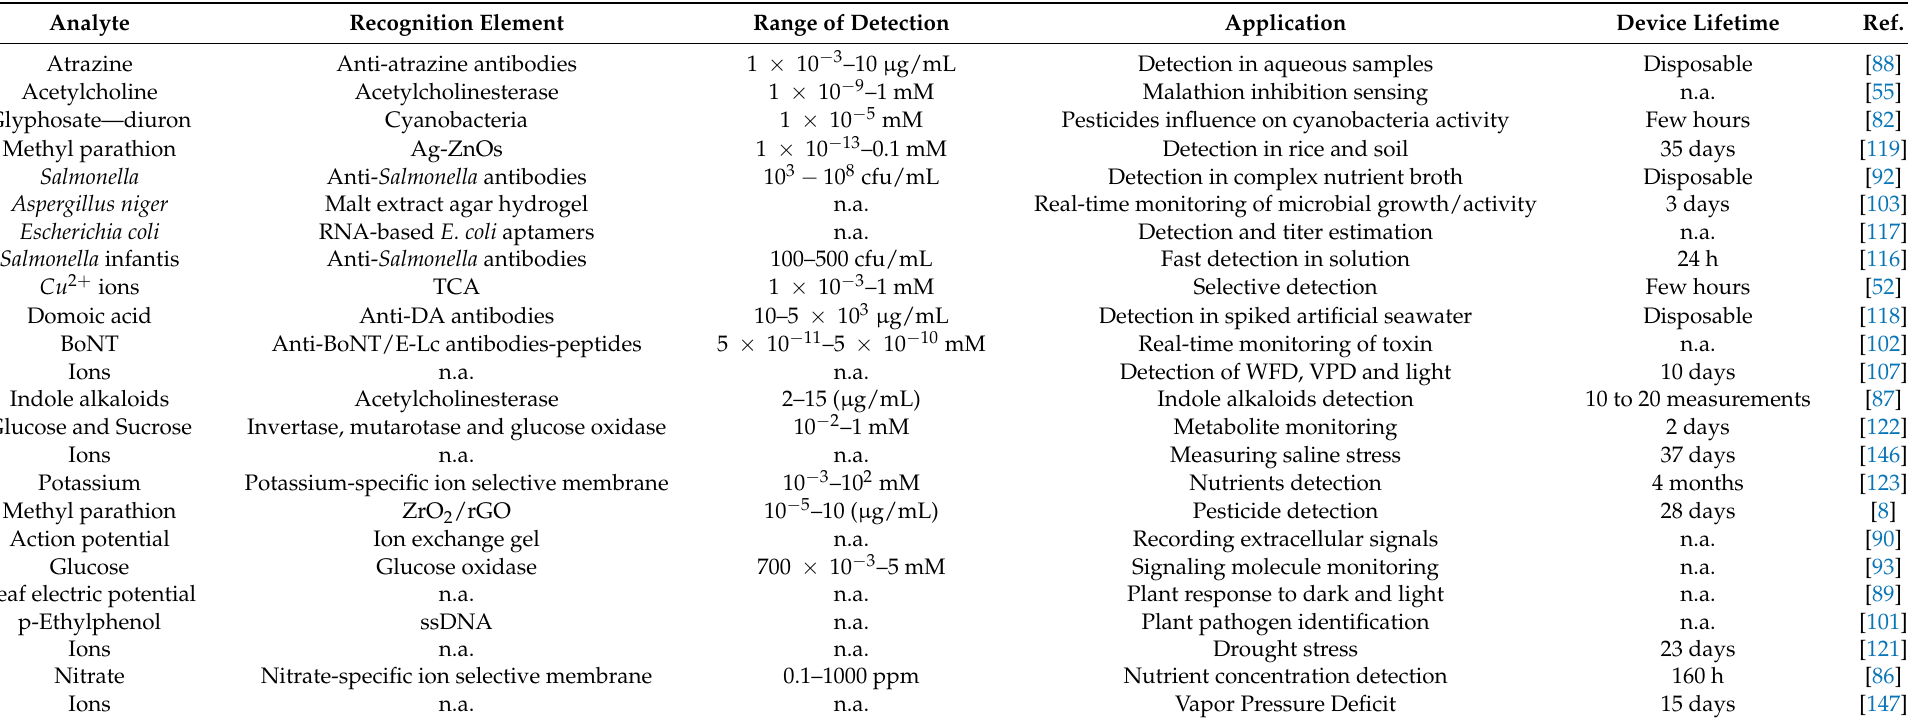
Table 2. Examples of recent studies that employed bio-FETs for detection of environmental contaminants and for agricultural plants monitoring